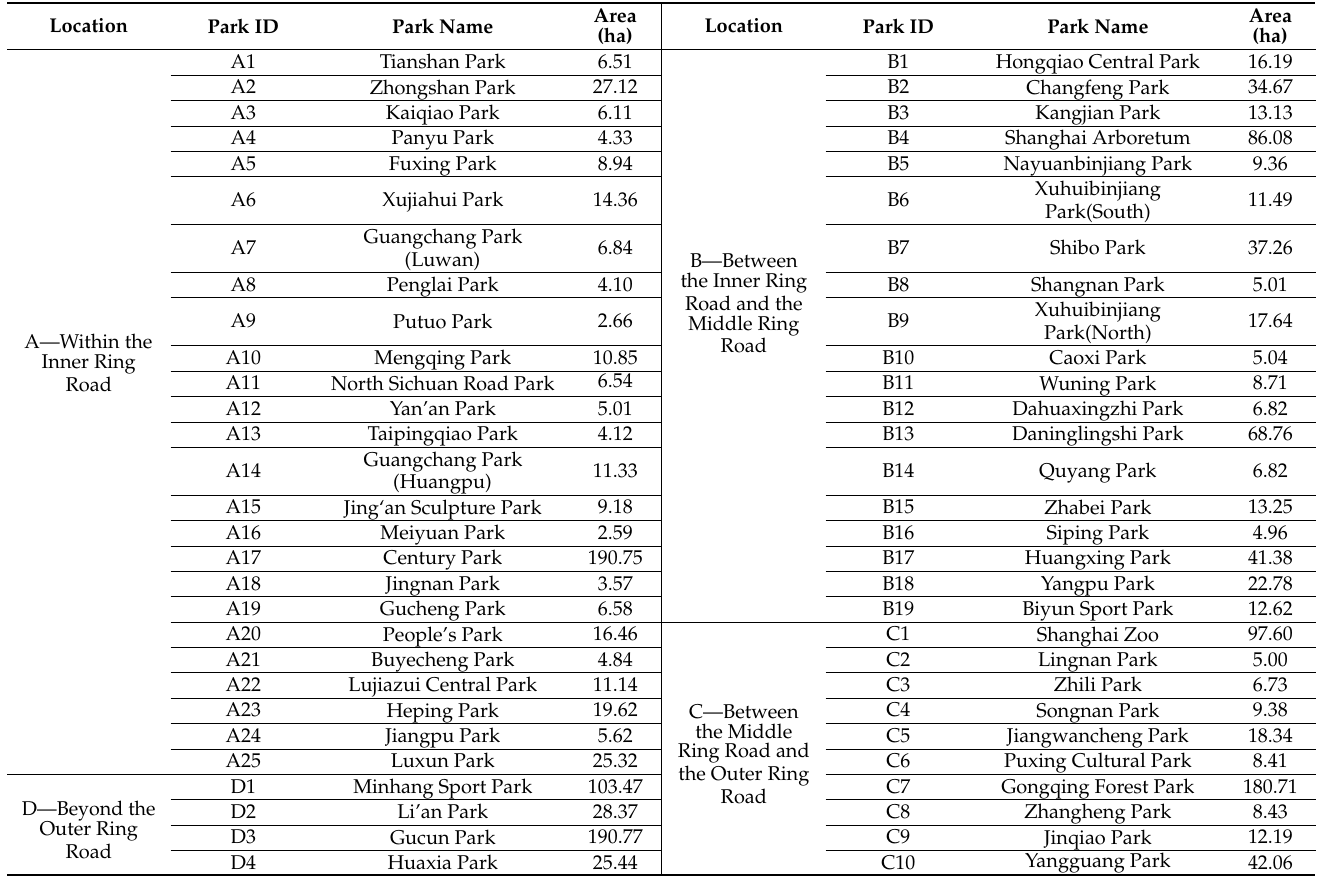
Table 1. Summary of the sampling